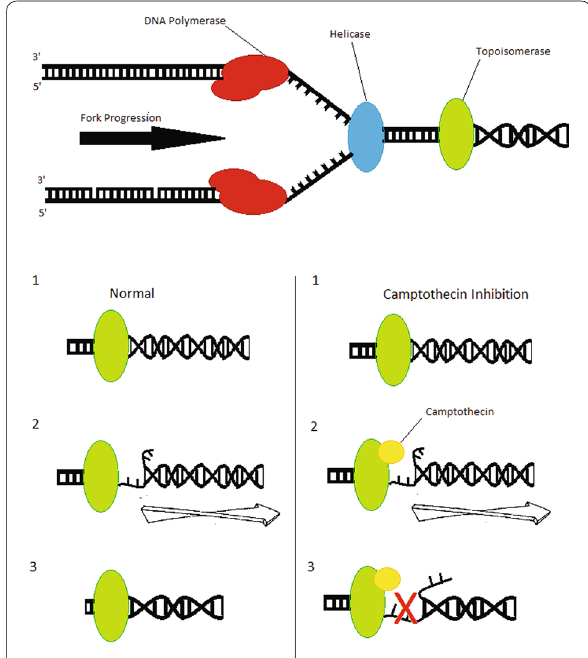
Fig. 4 A schematic illustrating replication fork arrest by a drug‑ aborted topoisomerase I‑DNA cleavable complex. In this model, the camptothecin trapped topoisomerase I‑DNA cleavable complex is viewed as a bulky DNA lesion which arrests the replication fork by blocking the movement of replication machinery. This blockage also alters the physical state of the cleavable complex and possibly leads to fork breakage at the complex site. At low levels of cleavable complexes, when only one replication fork is arrested, continued rep‑ lication by the other unimpeded fork on the same plasmid DNA leads to the formation of linearized replication products. The irreversible replication arrest and fork breakage may be the cause of camptoth‑ ecin’s S‑phase‑specific cytotoxicity [62, 63]